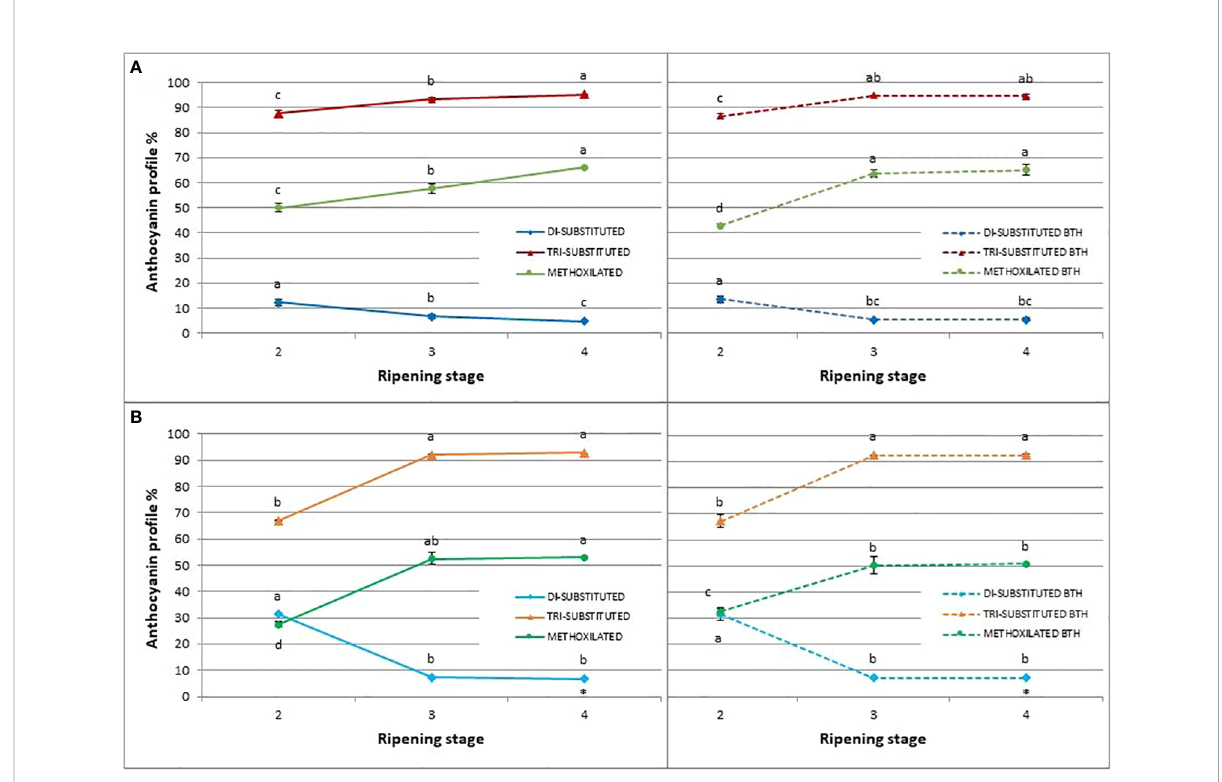
FIGURE 7 Effect of BTH treatment on relative proportion of di-substituted anthocyanins, tri-substituted anthocyanins, and methoxilated anthocyanins (%) in control (left) and treated (right) cv. (A) ‘ Duke ’ and (B) ‘ Brigitta ’ . Values represent means ± SE (n = 6). Different letters indicate statistical differences (p ≤ 0.05) among ripening classes and between control (left) and treatment (right), for each